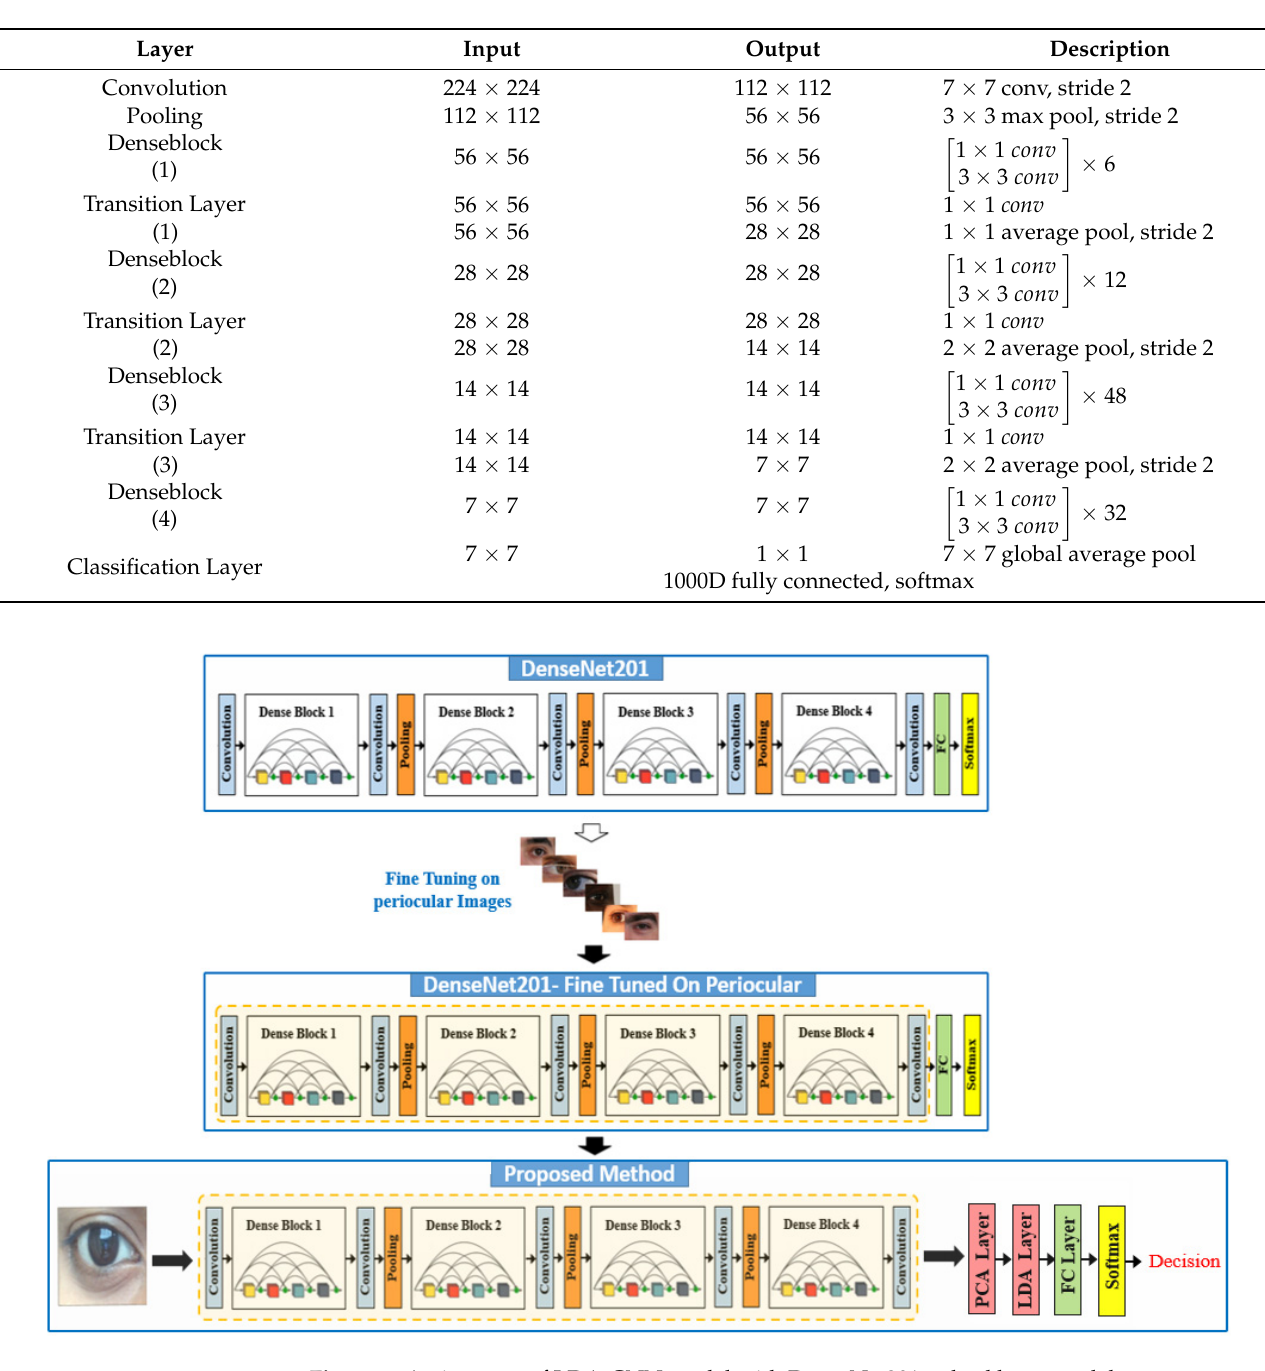
Table 1. The internal structure of DenseNet201 CNN model.